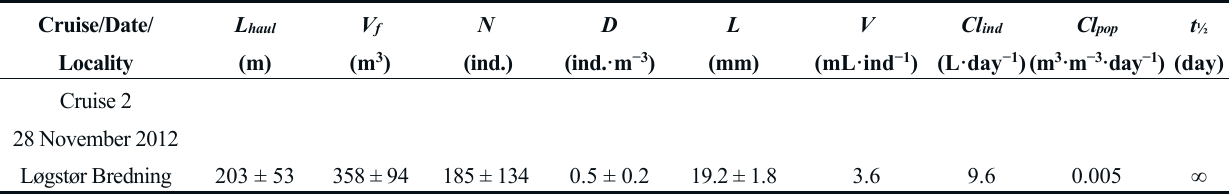
Table 3. Mnemiopsis leidyi collected in Løgstør Bredning 28 November 2012. L haul = haul length; V f = volume filtered per haul; N = total number of individuals caught; D = population density; L = oral–aboral body length; V = estimated individual body volume (Equation (3)); Cl ind = individual clearance rate (Equation (4)); Cl pop = population clearance rate (Equation (5)); t 1 / 2 = estimated half-life of copepods (Equation (6); t 1 / 2 > 3 weeks is indicated by ∞ ). Mean ± SD are